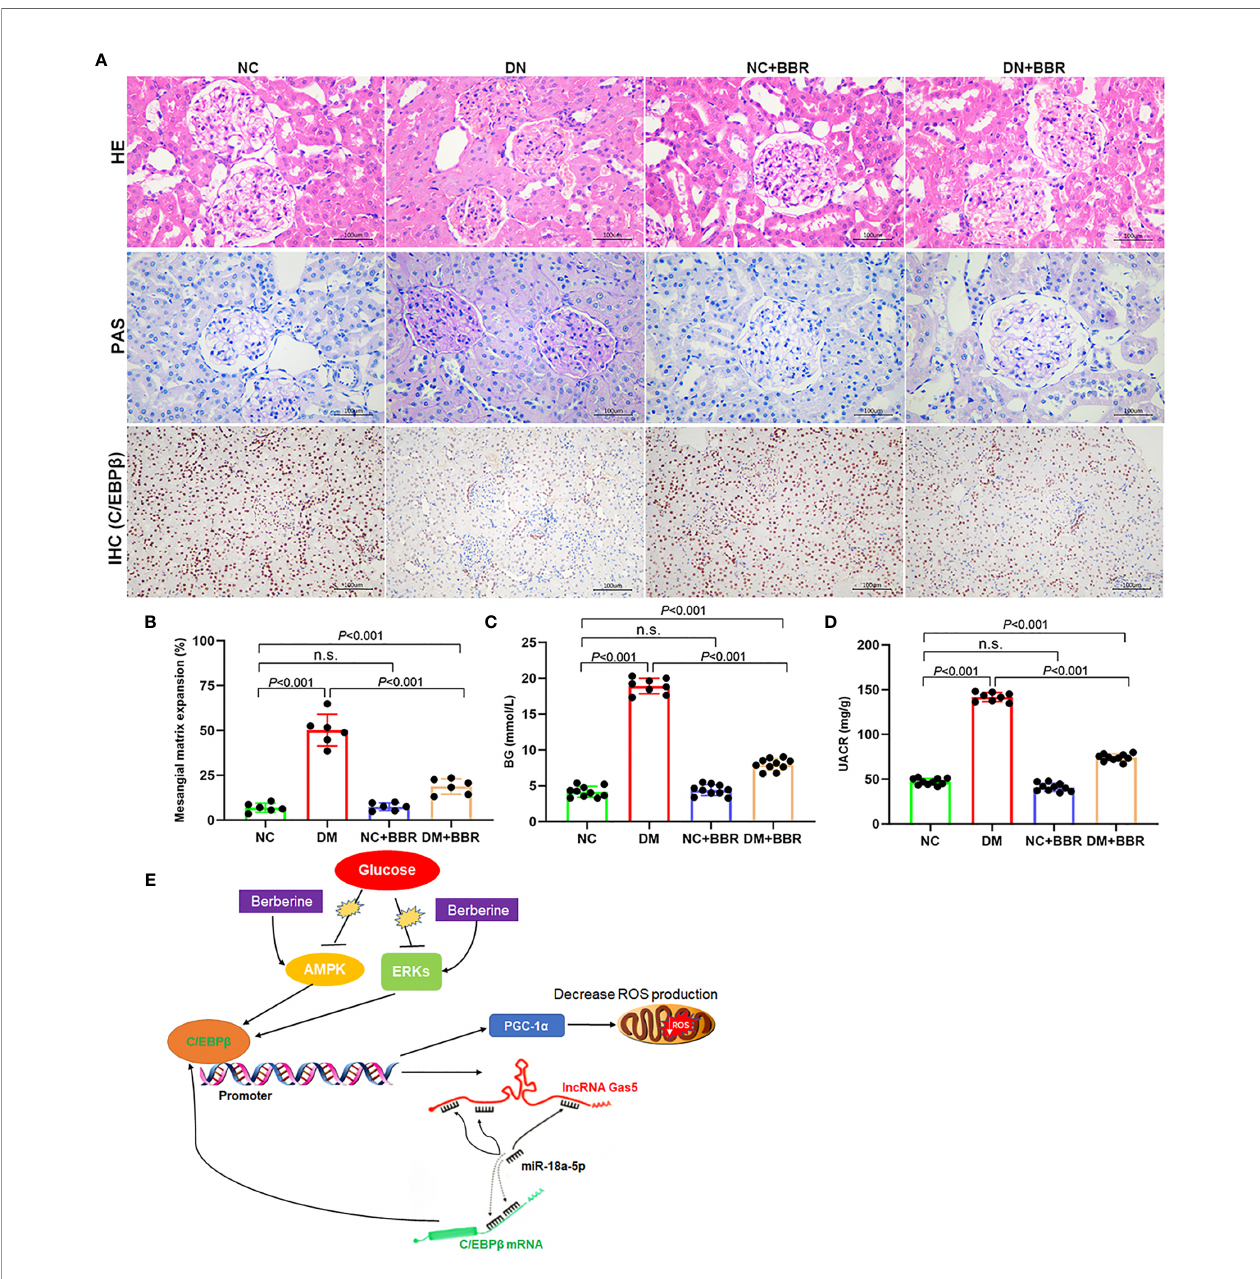
FIGURE 8 | Effect of BBR on STZ induced renal injury in DN rats. (A) HE, PAS, and immunohistochemical staining results. (B) Quanti fi cation of mesangial matrix expansion determined as the percentage of PAS-positive area/glomerular area. (C) BG levels in different groups. (D) UACR levels in different groups. (E) Schematic diagram of positive feedback loop of BBR activated C/EBP b /Gas5/miR-18a-5p. n.s., no signi fi